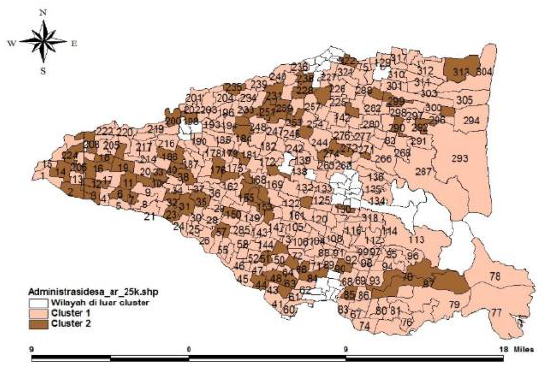
Figure 6: Clustering of Villages Based on Gender -Equality